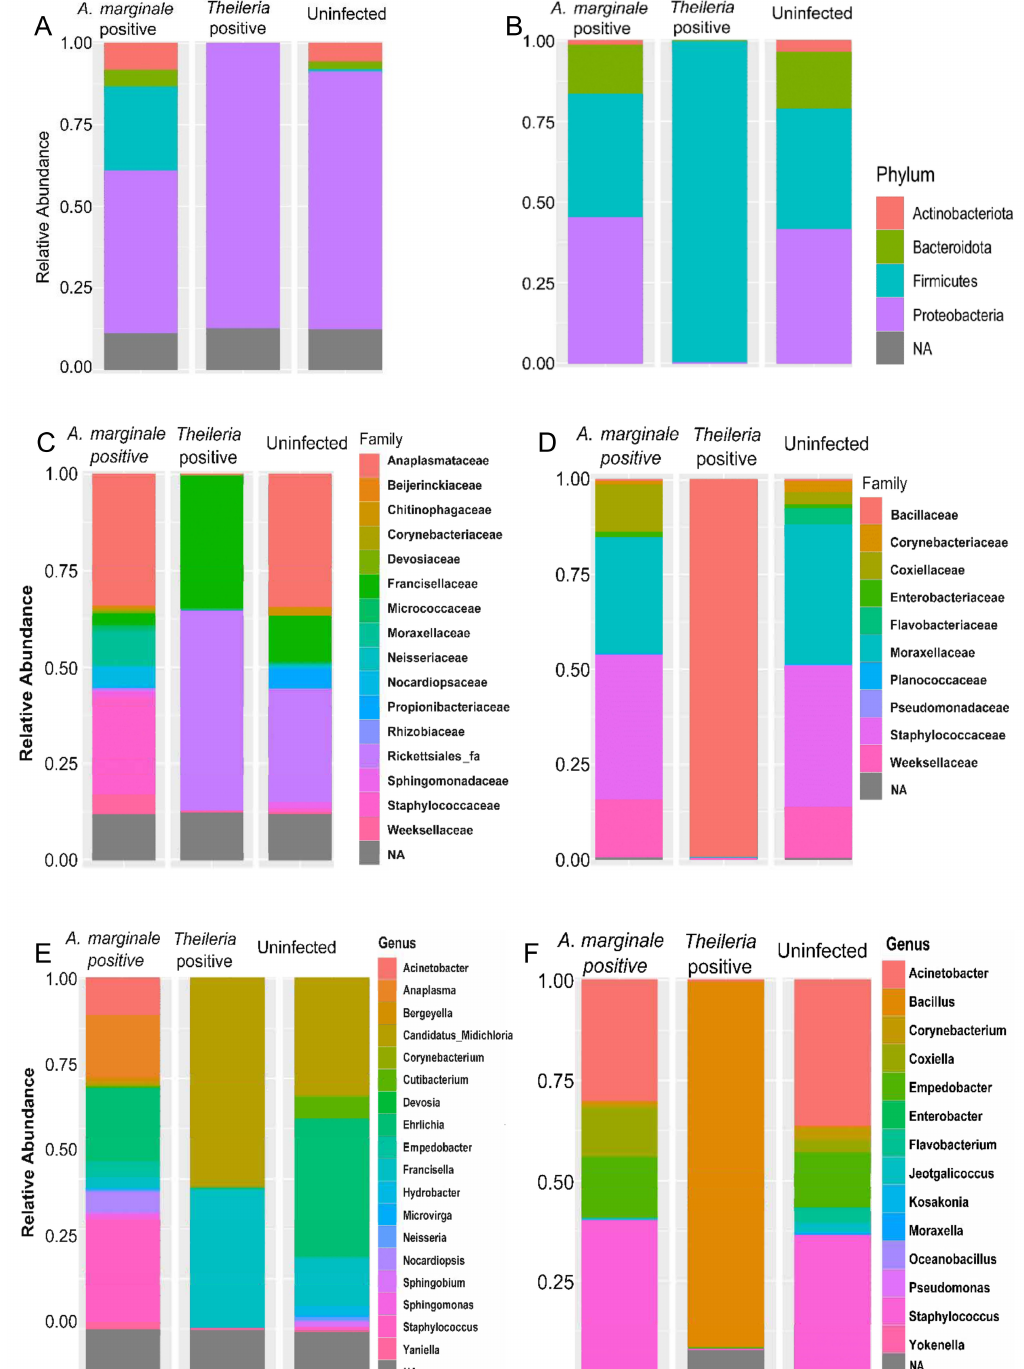
Figure 1. 16S bacteria abundance profiles of H. anatolicum and R. microplus . ( A , B ) Bacteria abundance at phylum. ( C , D ). Bacteria abundance at the family level. ( E , F ) Bacteria abundance at the genus level. Hyalomma anatolicum (left panel), R. microplus (right